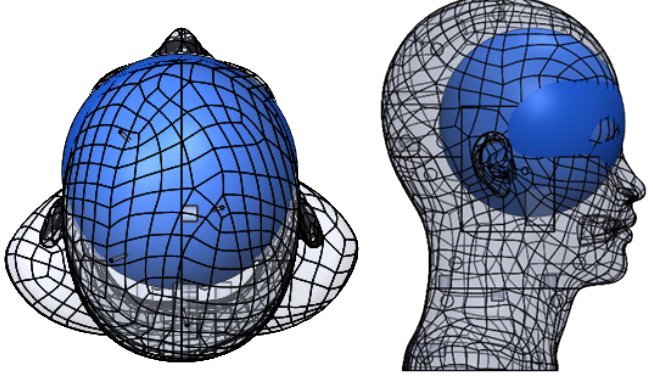
Figure 5. The sphere in which the point L 2 must